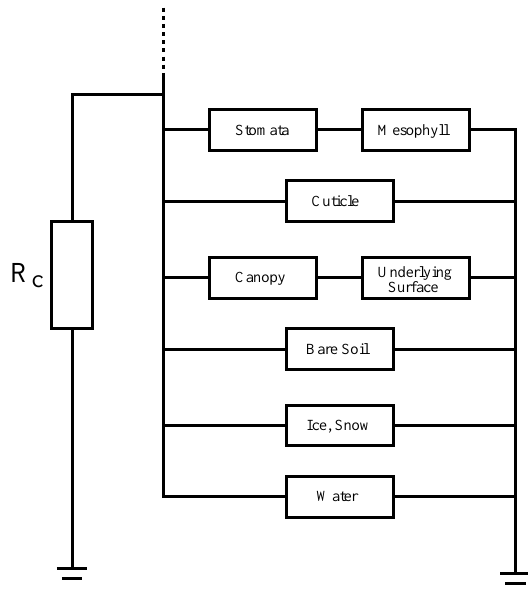
Fig. 1. Schematic of the terms used to calculate the overall surface or canopy resistance term, r c , for dry deposition. Adapted from Sanderson et al. (2007).